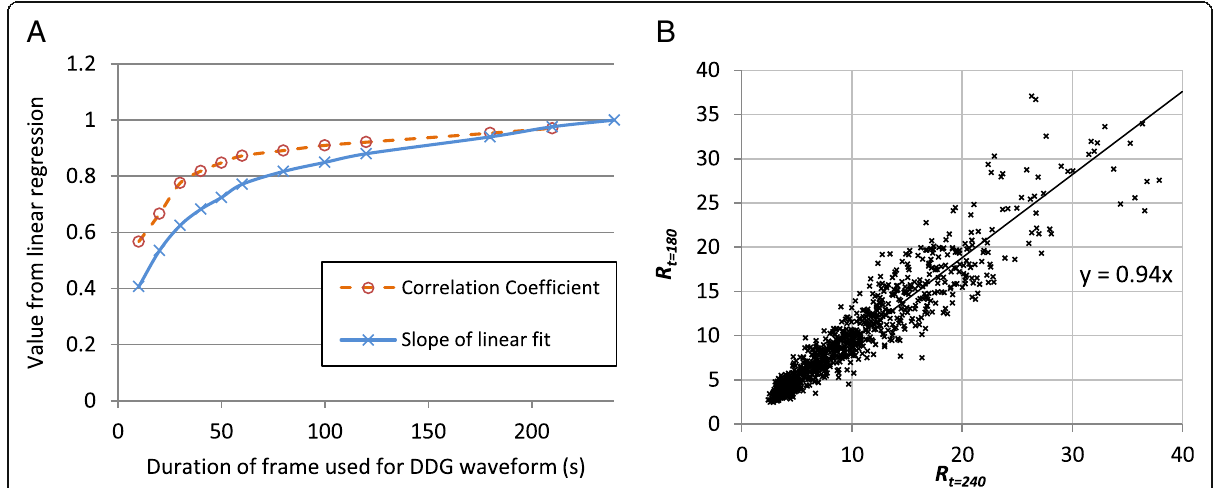
Fig. 6 a Results from linear regression, comparing R calculated from a 240-s duration acquisition to R found for the first t seconds of the acquisition. b Example regression, showing R t =180 compared to R t =240